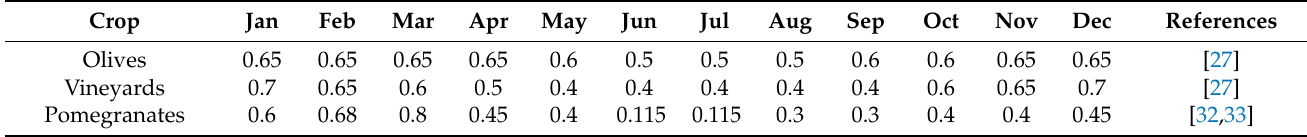
Table 1. Olives, vineyards, and pomegranates kc values.